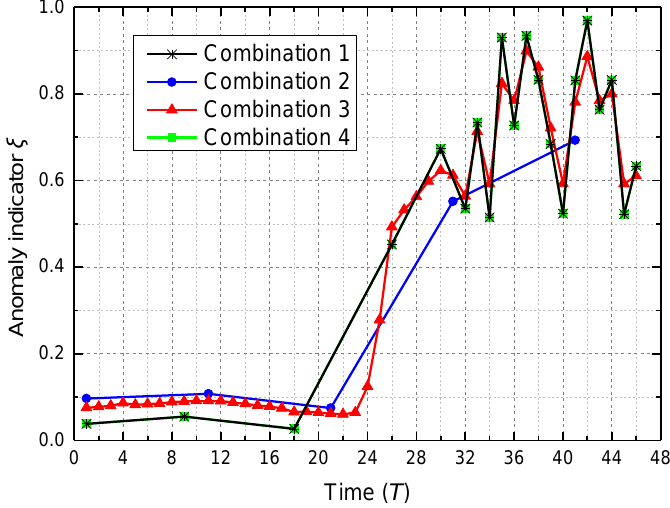
Figure 9. Anomaly indicator ξ of node 284 5 using methods with different combinations in a short-term